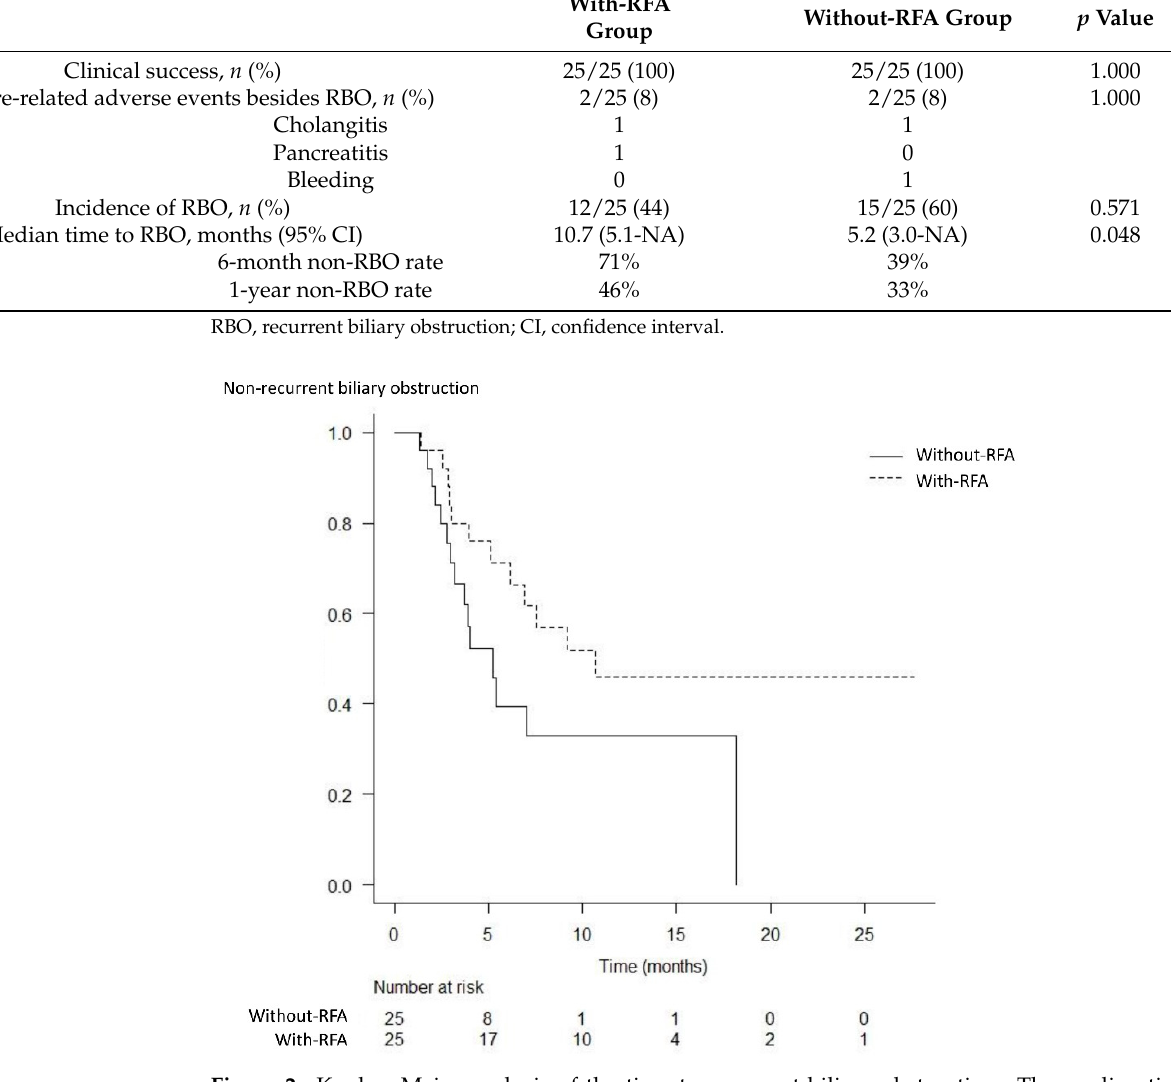
Table 2. Outcomes of stent placement with/without radiofrequency ablation.